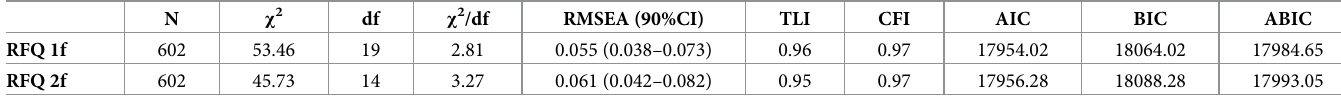
Table 1. CFA in non-clinical sample using a one-factor and a two-factor model: goodness-of-fit indices and comparison criterions.